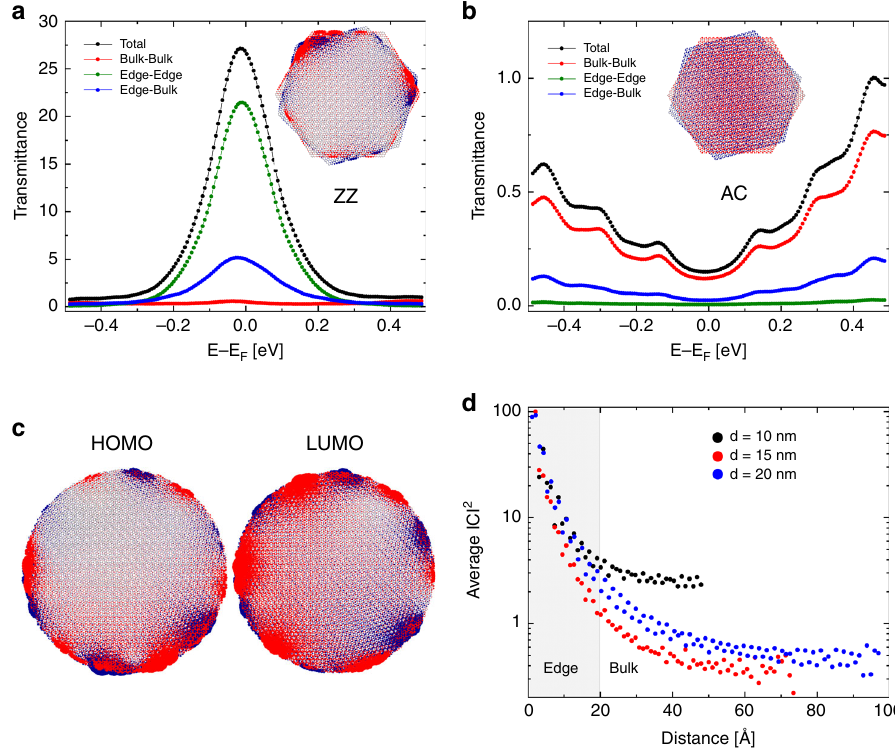
Fig. 3 Calculated interfacial transmittance and wave-function distribution. Calculated interfacial transmittance probability as a function of energy for a zigzag and b armchair hexagonal bilayer graphene junctions of side lengths of 7.6 and 7.8 nm, respectively, and angular mismatch of 15°. The total transmittance (black) is divided to show the individual contributions of bulk-bulk (red), edge-edge (green), and edge-bulk (blue). For the hexagonal fl ake calculations, edges are considered as 0.4 nm wide (see main text). Inset images show the highest occupied molecular orbitals (HOMO) of the a zigzag and b armchair hexagonal twisted bilayer interfaces. While for the armchair case, the wave-function uniformly distributes over the entire fl ake surface, the zigzag fl ake exhibits pronounced edge states, that are strongly localized at its circumference. c Calculated HOMO and LUMO orbitals for circular bilayer graphene structures with 15° rotational mismatch and a diameter of 20 nm (images for additional molecular orbitals next to the Fermi energy can be found in Supplementary Note 7). d Angularly averaged wave-function weights averaged over eight molecular orbitals in an energy range of ±0.44 meV around the Fermi energy, as function of radial distance for 3 different circular graphene bilayer interfaces of diameters 10, 15 and 20 nm and a twist angle of 15°. The edge region de fi nition (containing ~99% of the edge state probability) in the 20 nm circular fl ake is depicted in